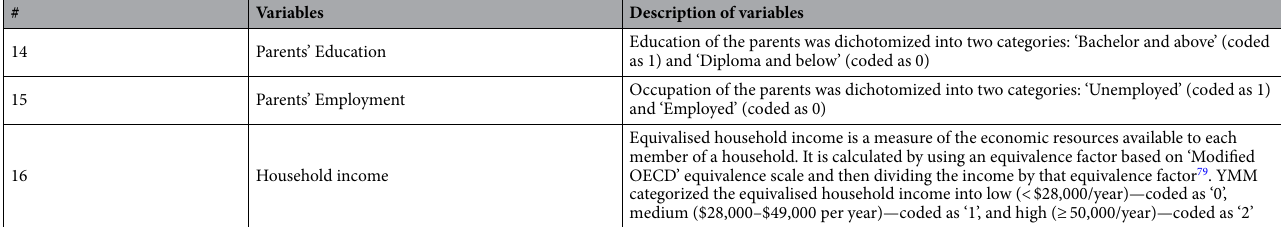
Table 1. List of variables.